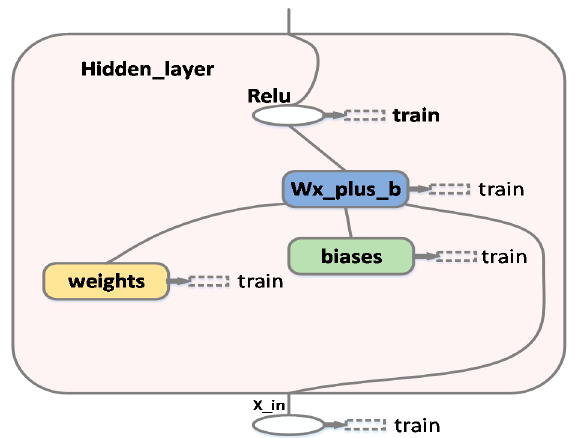
Figure 5. TensorFlow data flow diagram.